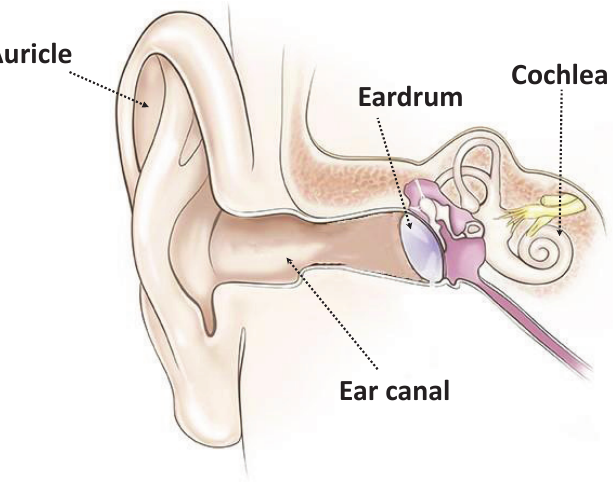
Figure 2. The physiological structure of human